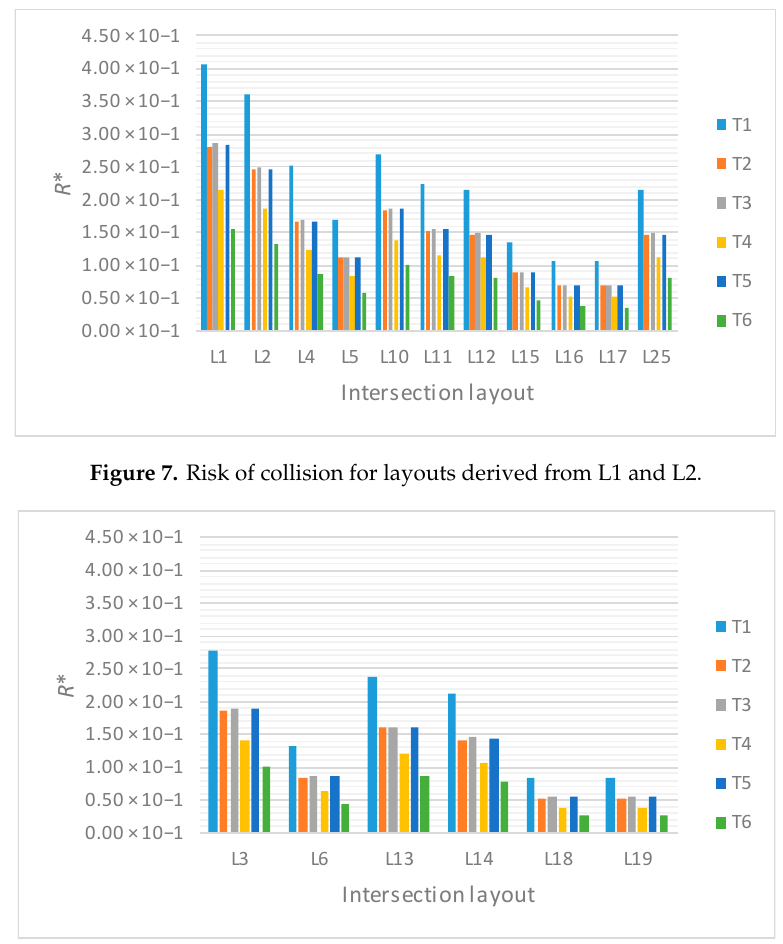
Figure 8. Risk of collision for layouts derived from L3.